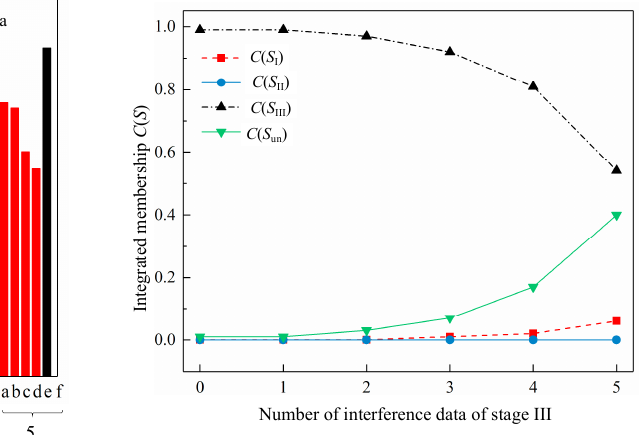
Quantity ratios of Methanosaeta to Methanobacterium of Stage III with di ff erent numbers of interference